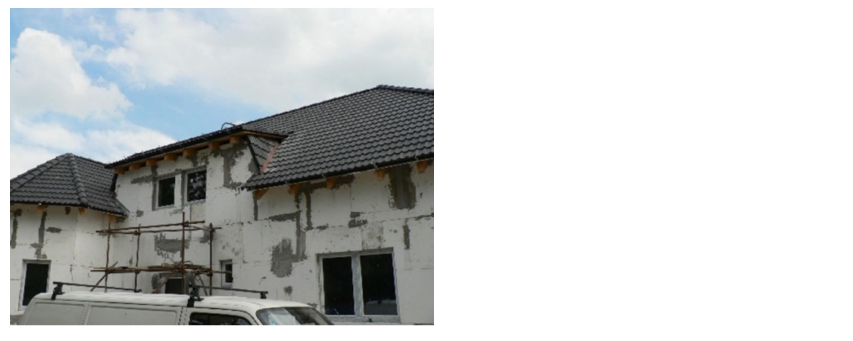
Figure 24. View of the implementation of the insulation of the perimeter panels. (Photo archive: Kal ú s, D.)